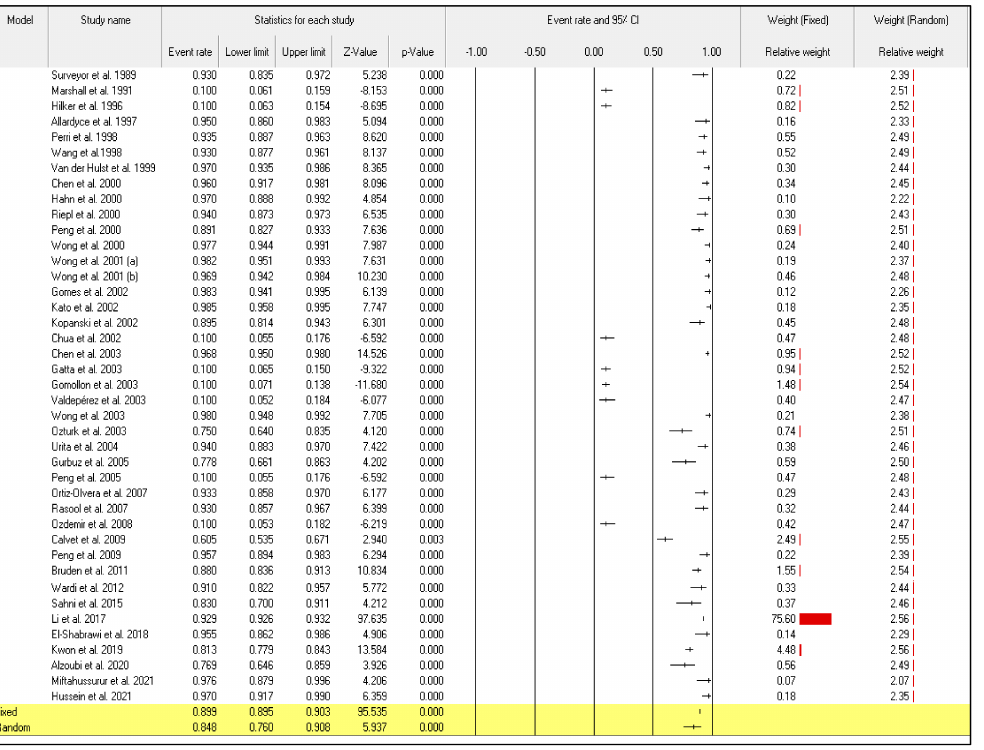
Figure 3. Forest plot from the fixed and random-effects analysis: the specificity of 13 C/ 14 C-urea breath tests in the diagnosis of Helicobacter pylori infection